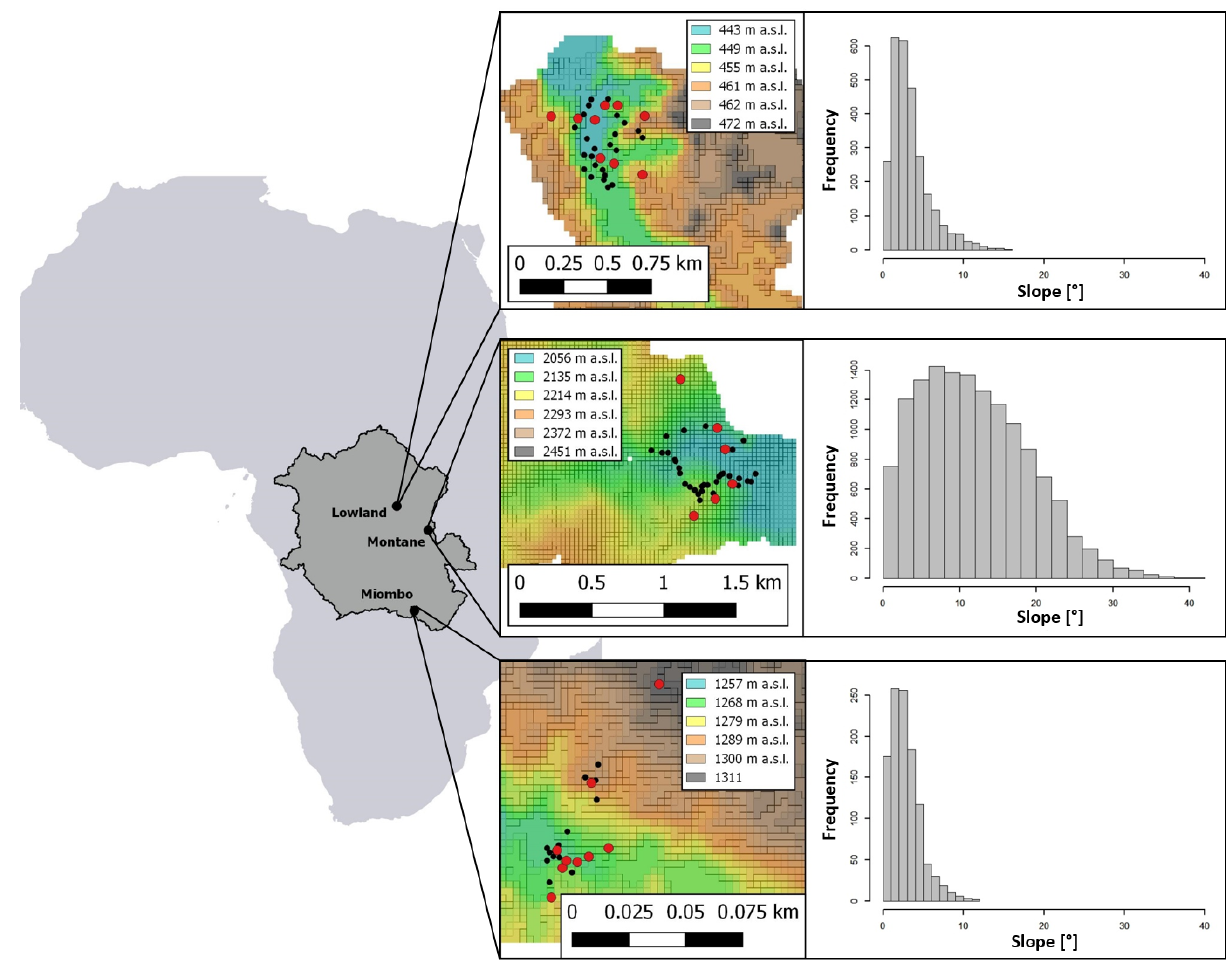
Figure 1. Location of the sampling sites; from left to right: dark grey area indicates the Congo Basin within Africa with forest site locations, red dots indicate locations of 1m soil profiles within each forest site, black dots indicate locations of topsoil sampling positions (0–20cm). Colors from the 30m DEMs represent elevation (in ma . s . l . ). Histograms on the right show the slope distribution of the respective sampling